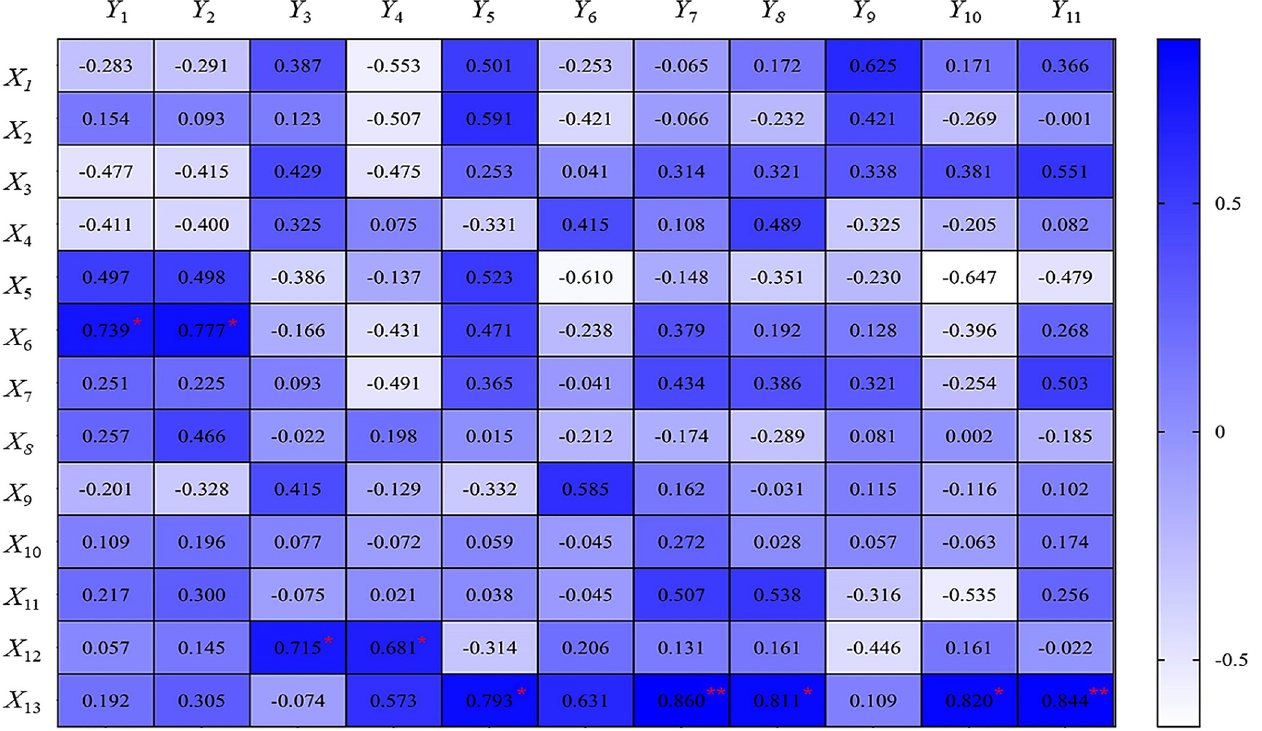
Fig 8. Relationship between leaf shape, SEM and AFM characteristics of the leaf surface, and dust retention index. Data are inter-index correlation coefficients (r). Significant correlations are indicated by � ( P < 0.05) and �� ( P < 0.01). Leaf shape and surface microtrait indicators include compound leaf length (X 1 ), compound leaf width (X 2 ), compound leaf petiole length (X 3 ), leaflet length (X 4 ), leaflet width (X 5 ), leaflet area (X 6 ), leaflet circumference (X 7 ), number of gullies